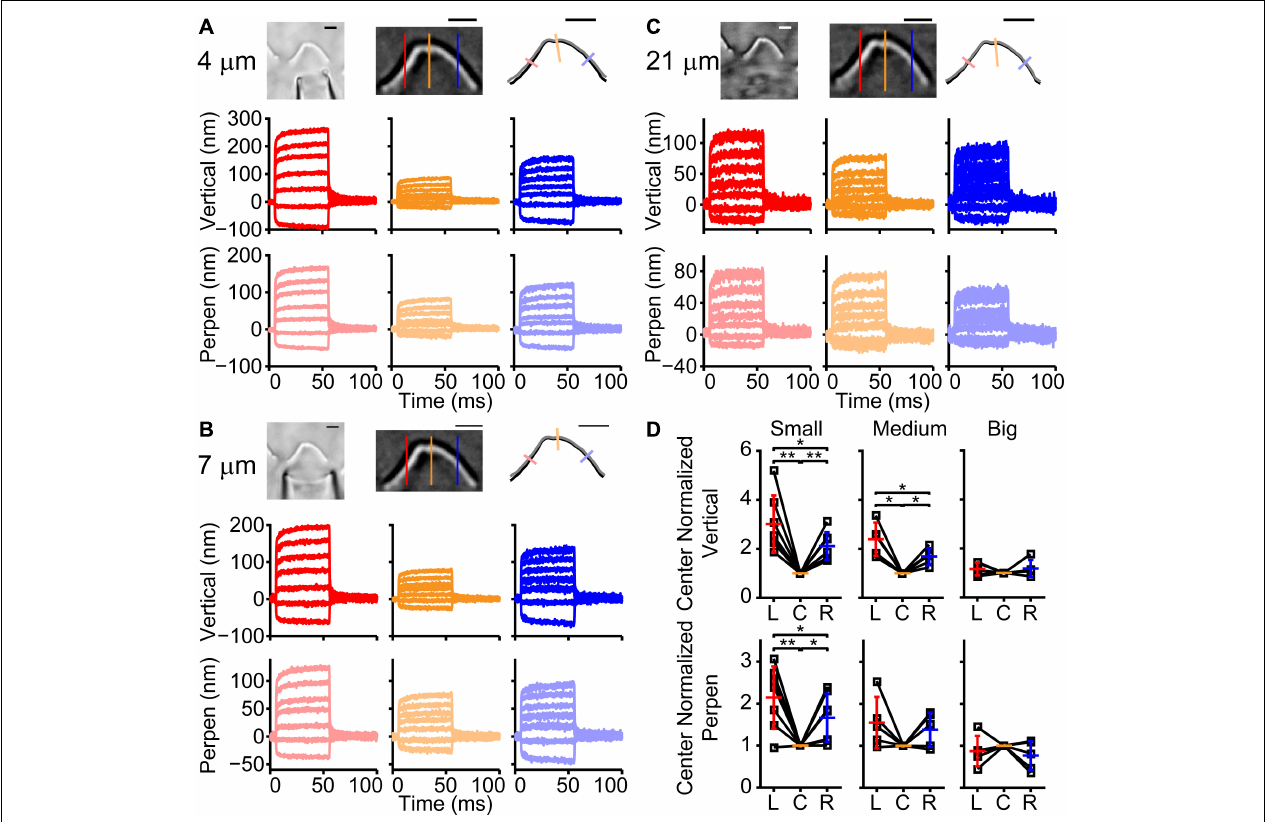
FIGURE 2 | Effect of fluid jet size on hair bundle motion on the same fixed hair bundle. (A) Raw (left) and filtered (middle) hair bundle images are shown with a small pipette fluid jet (4 µ m). The calculated hair bundle position with the corresponding perpendicular lines is shown on the right. Darker lines represent the vertical hair bundle motion at corresponding positions in the filtered image. Lighter lines indicate the perpendicular hair bundle motion along the lines in the right image. (B,C) The same analysis as in panel (A) is shown, but with a medium-sized pipette (7 µ m wide) in B and a large fluid jet (21 µ m wide) in C . Stimulus size was adjusted to yield comparable center bundle motion. (D) Summary of hair bundle motion amplitude for the largest step size with left (L) and right (R) side motion normalized to the center (C). Individual cells are shown and demonstrate that the larger pipettes deliver more uniform hair bundle motion when analyzing the vertical or perpendicular hair bundle motion. n = 7, 5, 5 for small, medium, and large pipettes, respectively. Scale bars = 2 µ m. * p < 0.05, ** p <